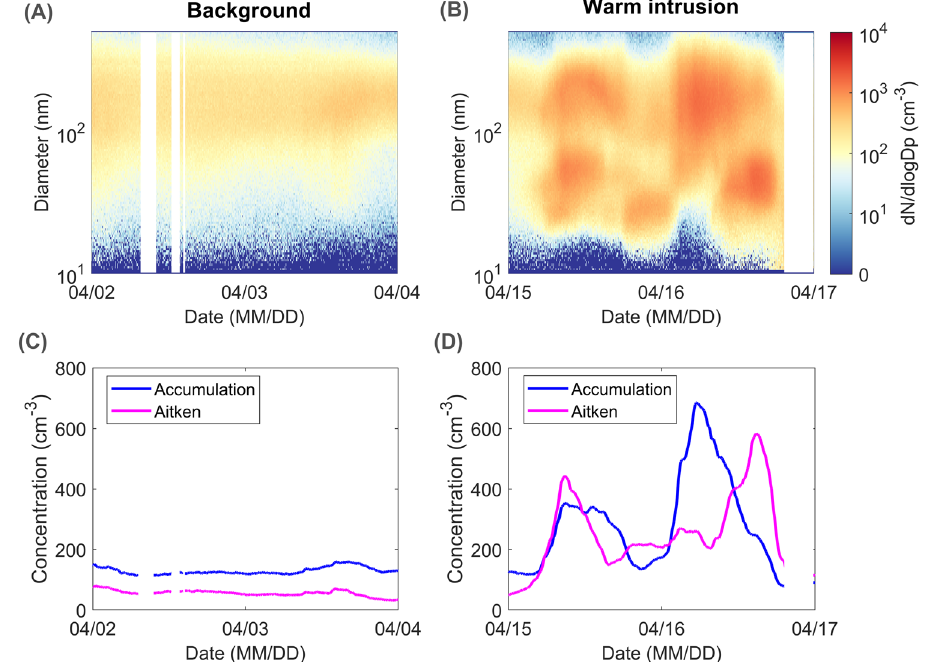
Fig. 3 | Background and warm intrusion particle number size distribution. Particle number size distribution during the ( A ) background period and ( B ) warm air-mass intrusion event. Accumulation mode (blue) and Aitken mode (magenta)